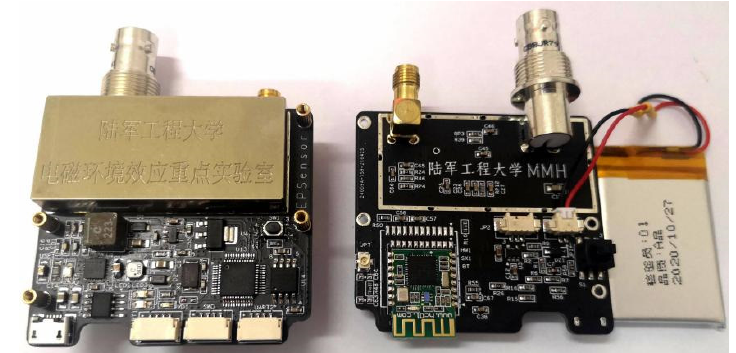
Figure 5. Electrostatic potential sensor.